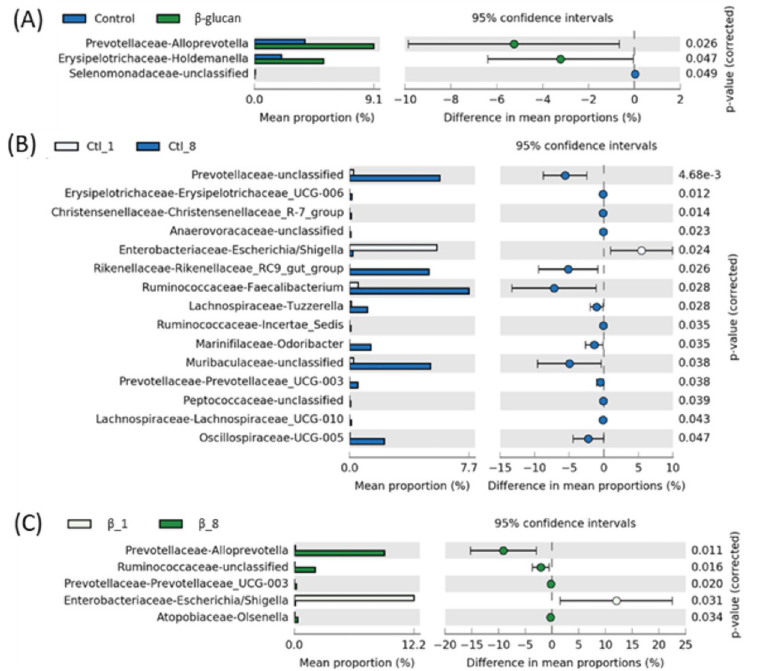
Fig 5. Bacterial genera composition in dairy calves’ feces fed milk replacer supplemented or not with β -glucans. Scatter-plot based on Welch’s t-test with Benjamini–Hochberg correction constructed in STAMP (P < 0.05). (A) differences between treatments; (B) differences between week 1 and week 8 in control group (Ctl), and (C) differences between week 1 and week 8 in β -glucans supplemented